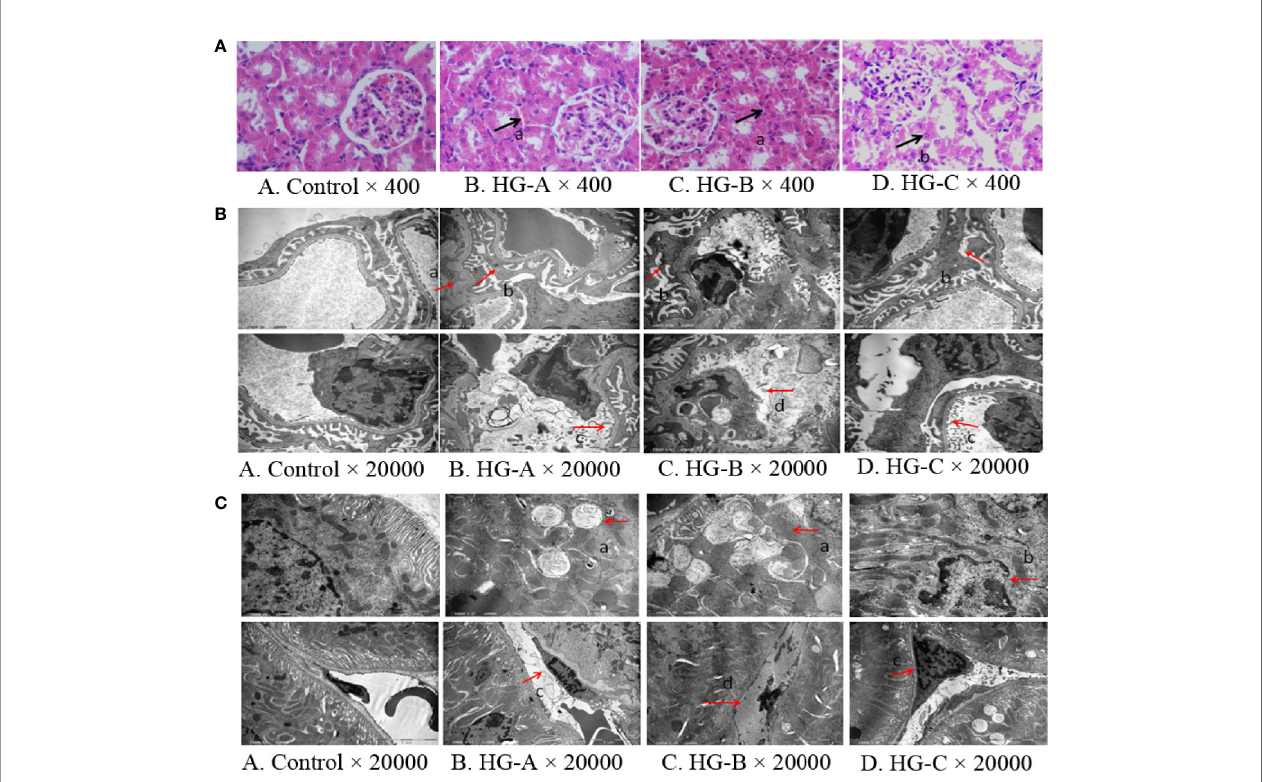
FIGURE 2 | Renal morphological alterations under acute hyperglycemic state. (A) Renal morphological alterations under optical microscope. Arrow “ a ” indicates swelling of tubular epithelial cells and tubular stenosis, arrow “ b ” indicates fragmentation of tubular epithelial cells. (B) Ultrastructural alterations of glomerulus. Arrow “ a ” indicates thickening of glomerular basement membrane; arrow “ b ” indicates fusion of foot process; arrow “ c ” indicates enlargement of glomerular endothelial cell window; and arrow “ d ” indicates apoptosis of endothelial cells. (C) Ultrastructural alterations of renal tubular epithelial cells. Disorder of tubular epithelial cell labyrinths, vesicles development (arrow a), apoptotic changes of nucleus (arrow b) were noticed in tubular epithelial cells and swelling or apoptosis of nucleus (arrows c and d) were indicated in renal tubular vascular endothelial cells in hyperglycemia groups. Control, control group; HG-A, hyperglycemia group A; HG-B, hyperglycemia group B; HG-C, hyperglycemia group